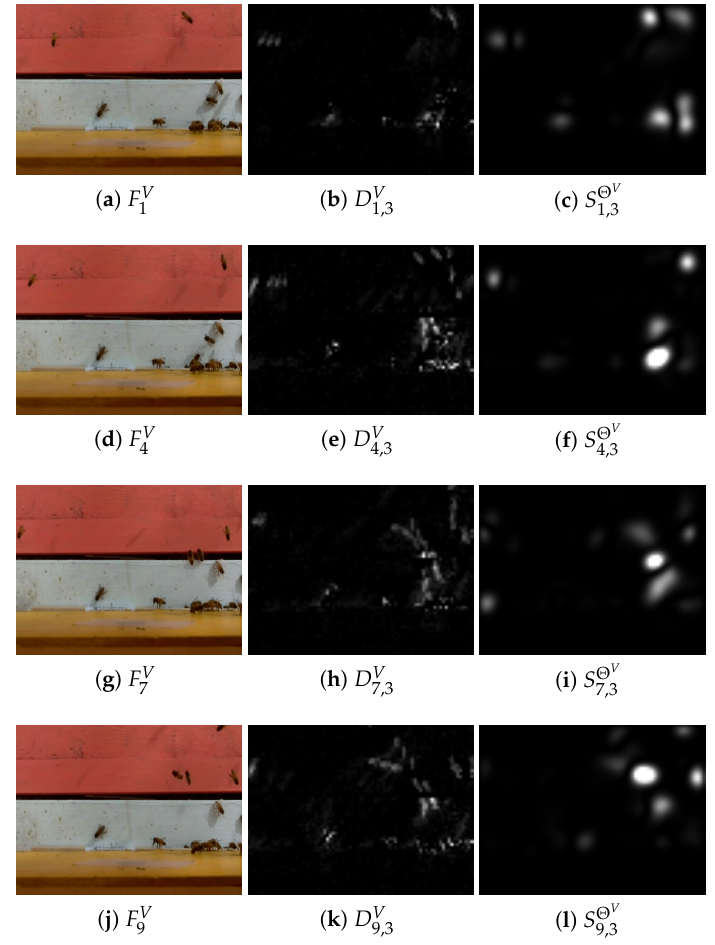
Figure 8. Frames F V , F V , F V , F V in left column are from video V in Figure 2; frames 7 9 1 4 D V , D V , D V , D V in middle column are corresponding difference frames computed from frames in 7,3 9,3 1,3 4,3 left column; frames S Θ V , S Θ V , S Θ V , S Θ V are computed from corresponding frames in middle column 7,3 9,3 1,3 4,3 by smoothing them and thresholding their pixel values at Θ V =